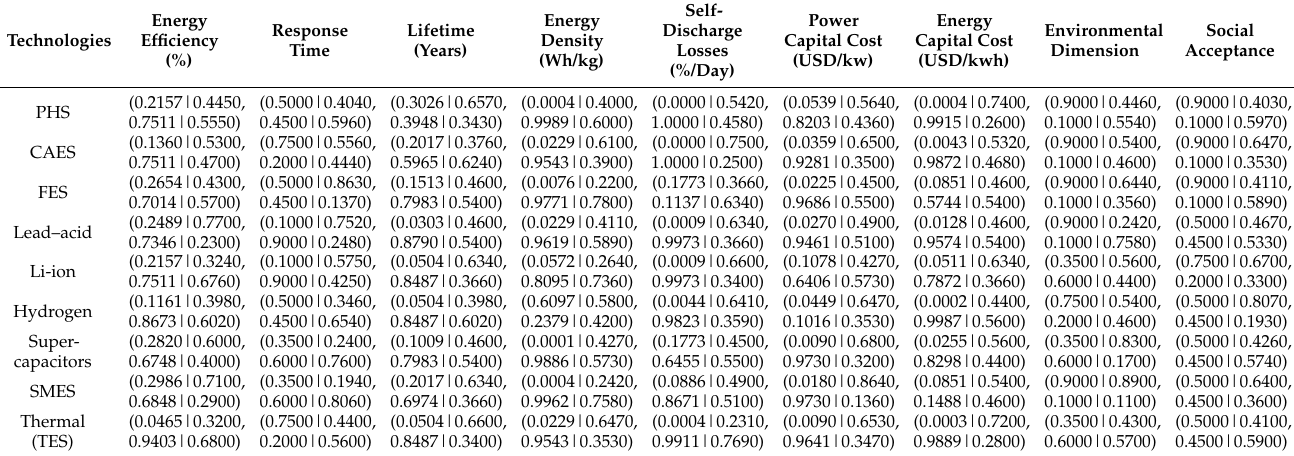
Table A10. Initial decision matrix of Expert